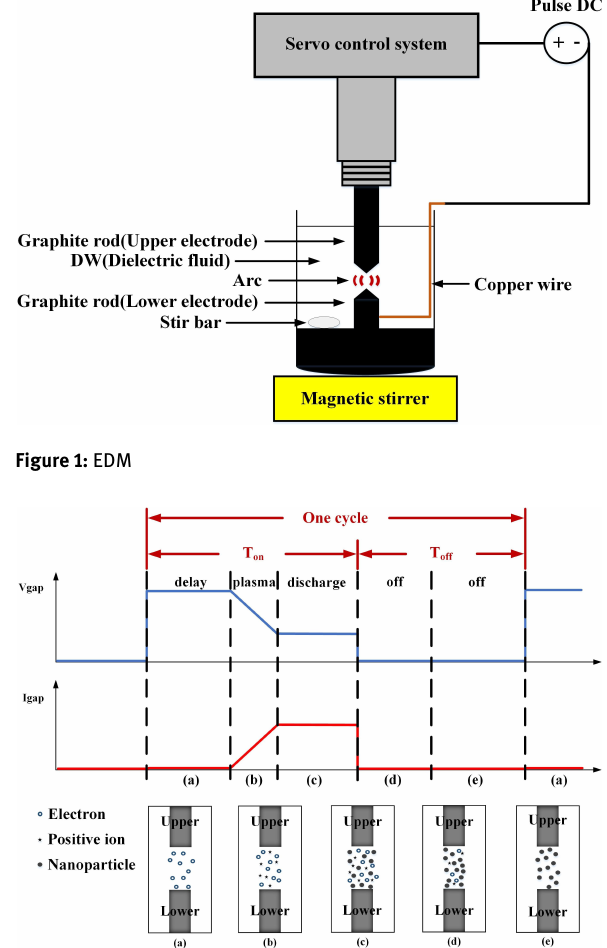
Figure 2: Arc discharge process: (a) discharge begins; (b) ionization; (c) melting; (d) discharge cut-off; (e) insulation